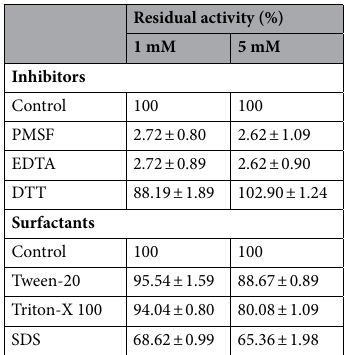
Table 3. Residual activity of SLSP-k in the presence of inhibitors and surfactants.